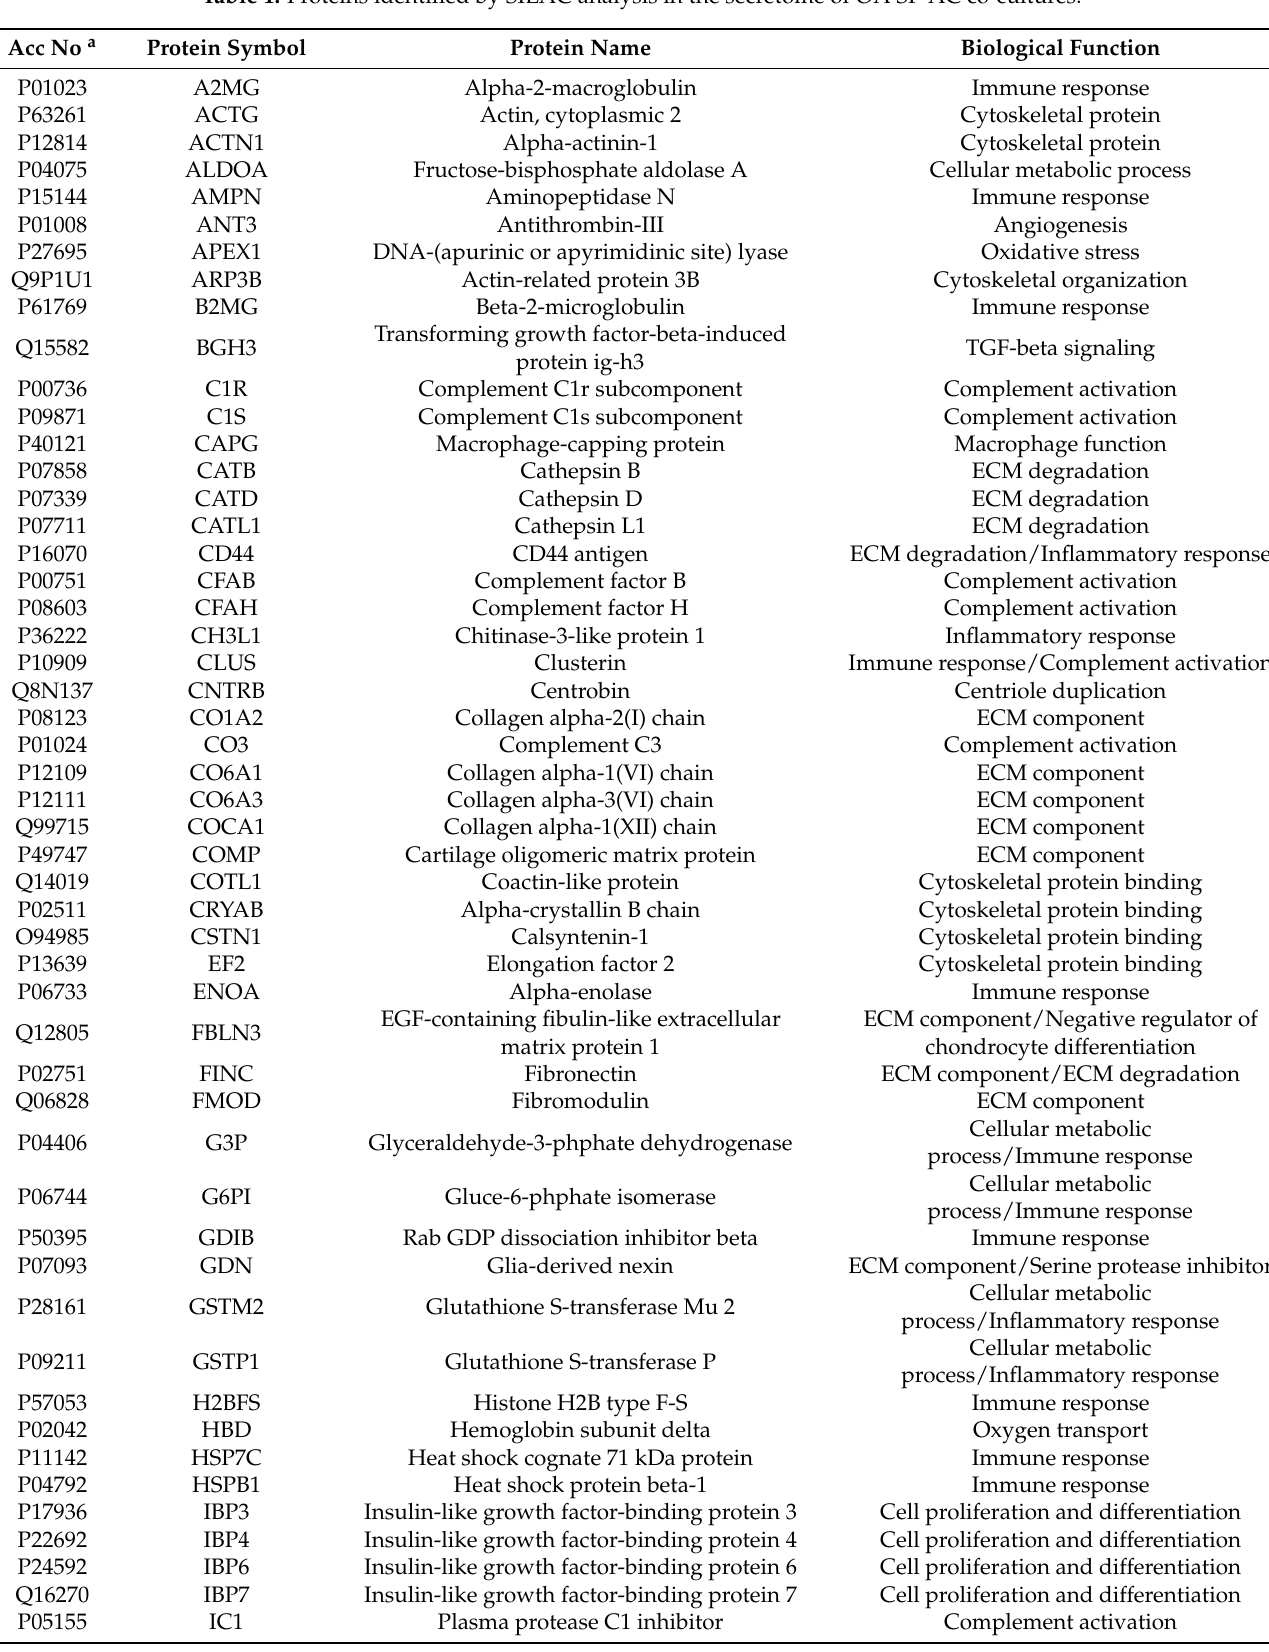
Table 1. Proteins identified by SILAC analysis in the secretome of OA SF-AC